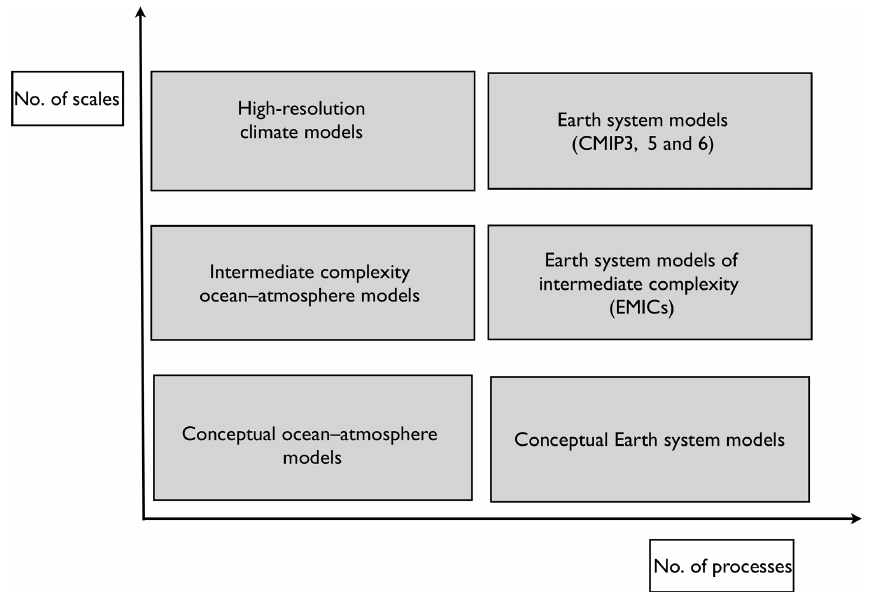
Figure 3. Organization of climate models according to the two model traits: number of processes and number of scales (Dijkstra,